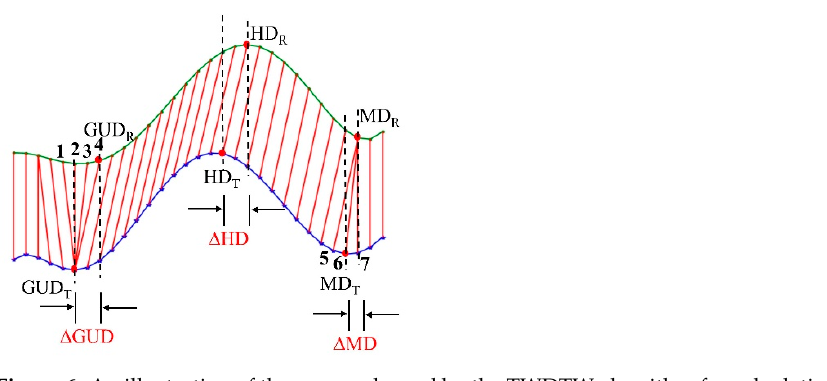
Figure 6. An illustration of the approach used by the TWDTW algorithm for calculating the difference between the reference curve (green) and target curve (blue).